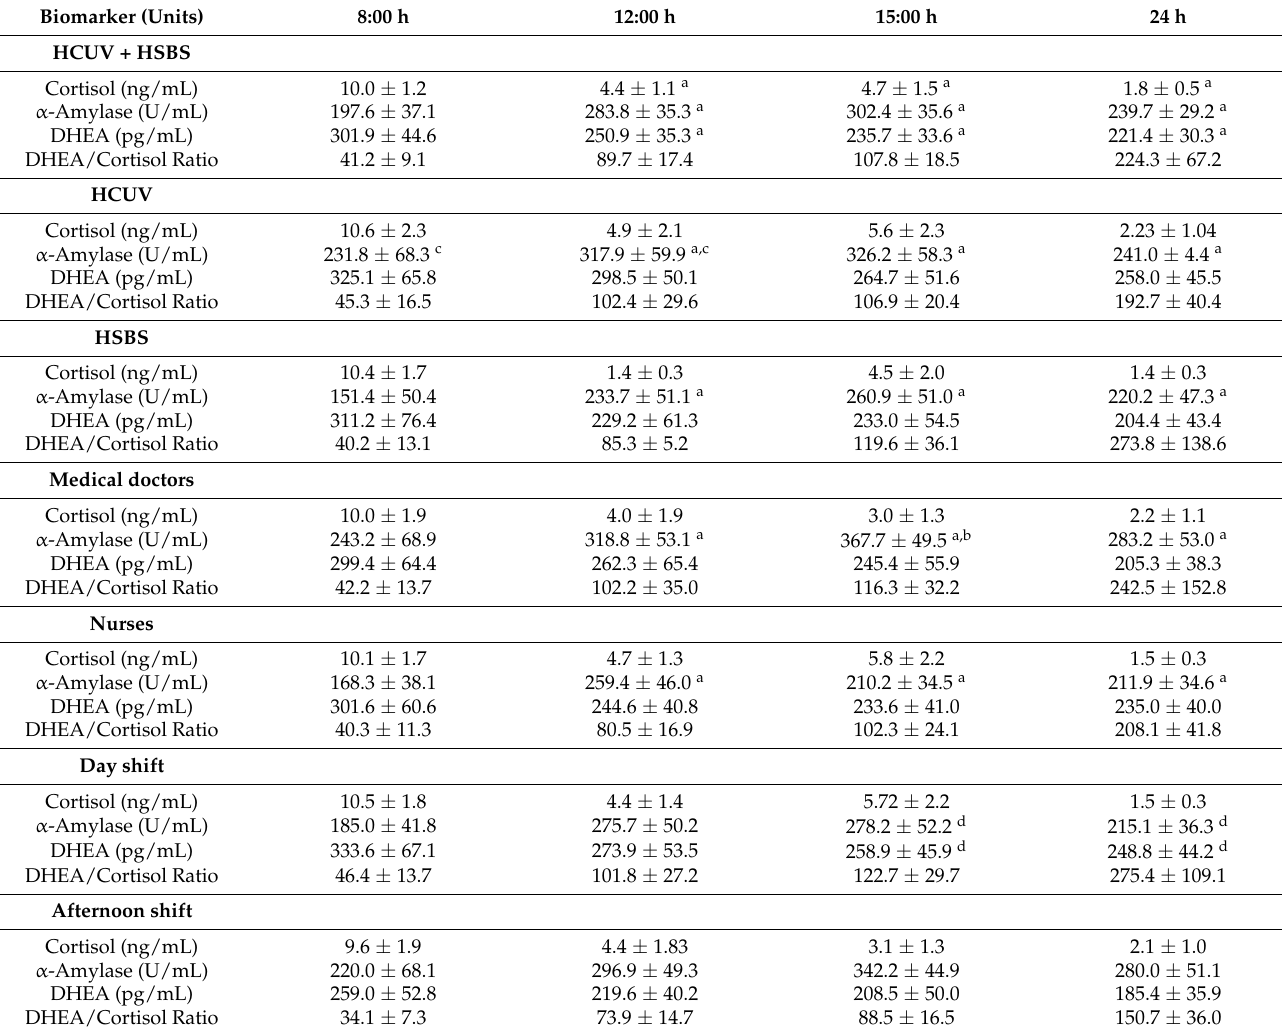
Table 2. 95% confidence intervals for the mean, calculated using bootstrap for normalization. Measurements of variations (mean + SD) throughout the working day of salivary cortisol, α -amylase and DHEA.